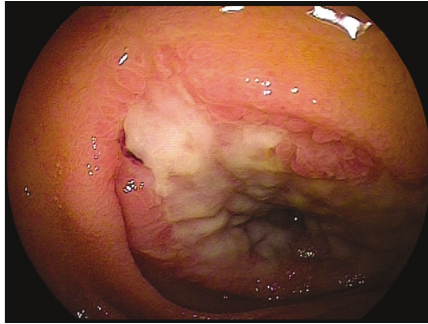
Figure 5: Prevailing infiltration with plasmatic cells was identified in all layers of the small intestine. Immunohistochemistry, anti- CD138 staining. Original magnification 100x. Courtesy of Vˇera